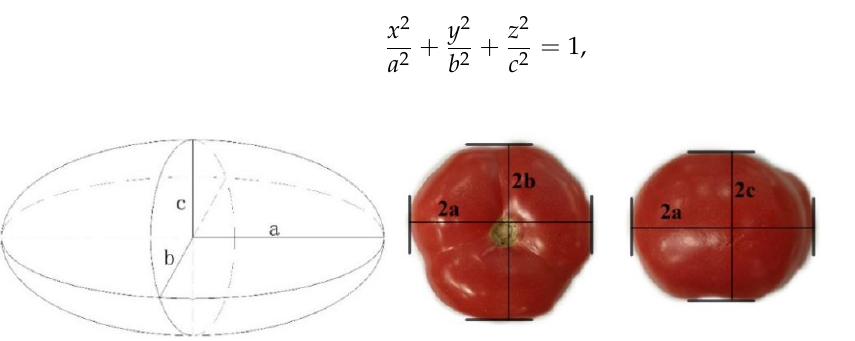
Figure 2. Ellipsoidal 3D contour and its correspondence in tomato.